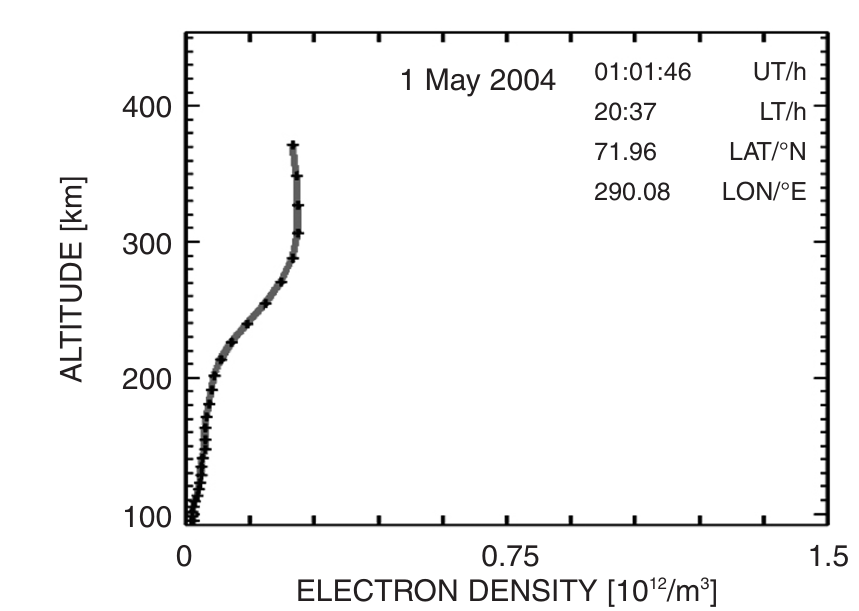
Fig. 6. Electron density profile retrieved from CHAMP IRO measurements on 1 May 2004 at high